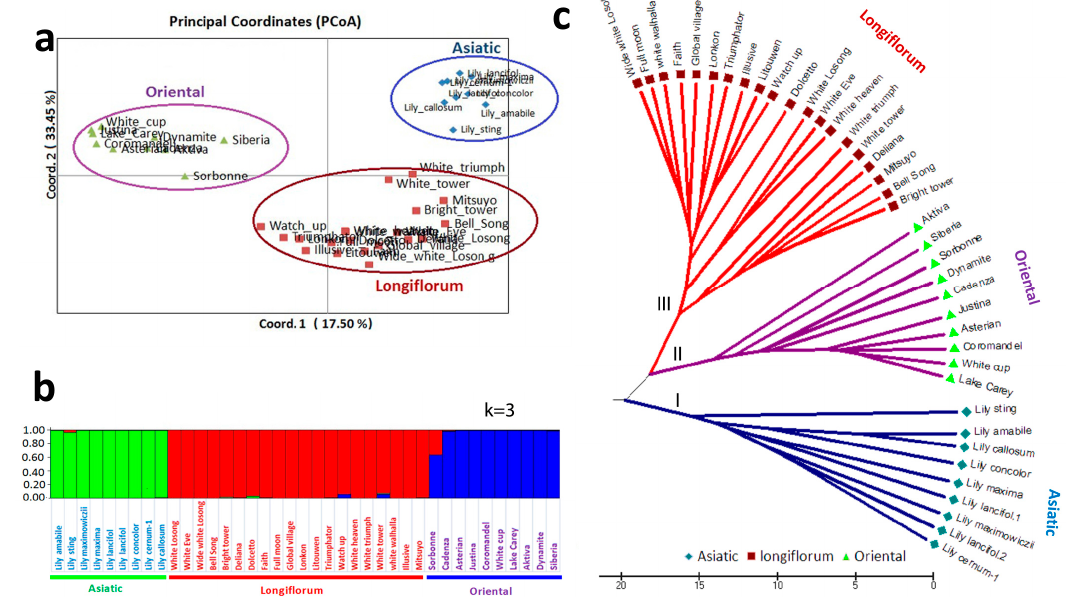
Figure 4. Population structure of Lily germplasm. ( a ) Principal Coordinates Analysis (PCoA) using distance matrix values for 39 lily accessions obtained from primers for 14 TFSSRs, colored circles represent the groups of lily accessions; ( b ) Population structure analysis of 39 lily accessions using STRUCTURE V2.3.4, each vertical bar represents one accession; ( c ) Phylogenetic tree generated by using the variations of PCR amplicon with the 39 lily accessions.